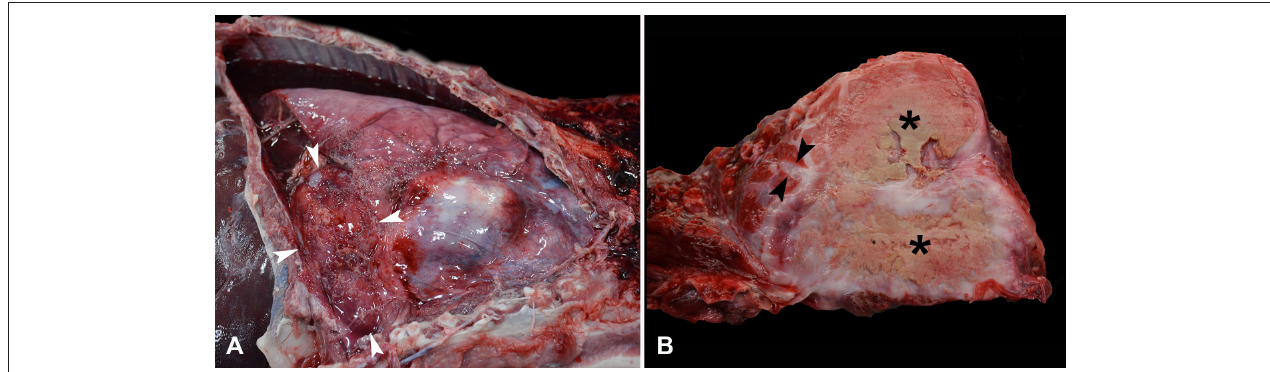
FIGURE 1 | Photographs from gross post-mortem examination of an adult castrated male Vietnamese pot-bellied pig with acute dyspnea and lethargy. (A) The pleural cavity contains a moderate amount of dark red serosanguinous effusion with abundant fibrin along the pleura of the left lung lobes, ventral right lung lobes, and adjacent pericardial sac. The left caudal lung lobe (denoted by white arrowheads) is markedly expanded and displaced to the right of the midline. (B) On cut surface, the left lung lobe is markedly expanded by multifocal granulomas with dry yellow to tan caseonecrotic centers (*) surrounded by firm, smooth, pale tan, fibrous tissue that blends into adjacent pulmonary parenchyma. The interlobular septa of the adjacent lung are moderately expanded with edema (arrowheads).